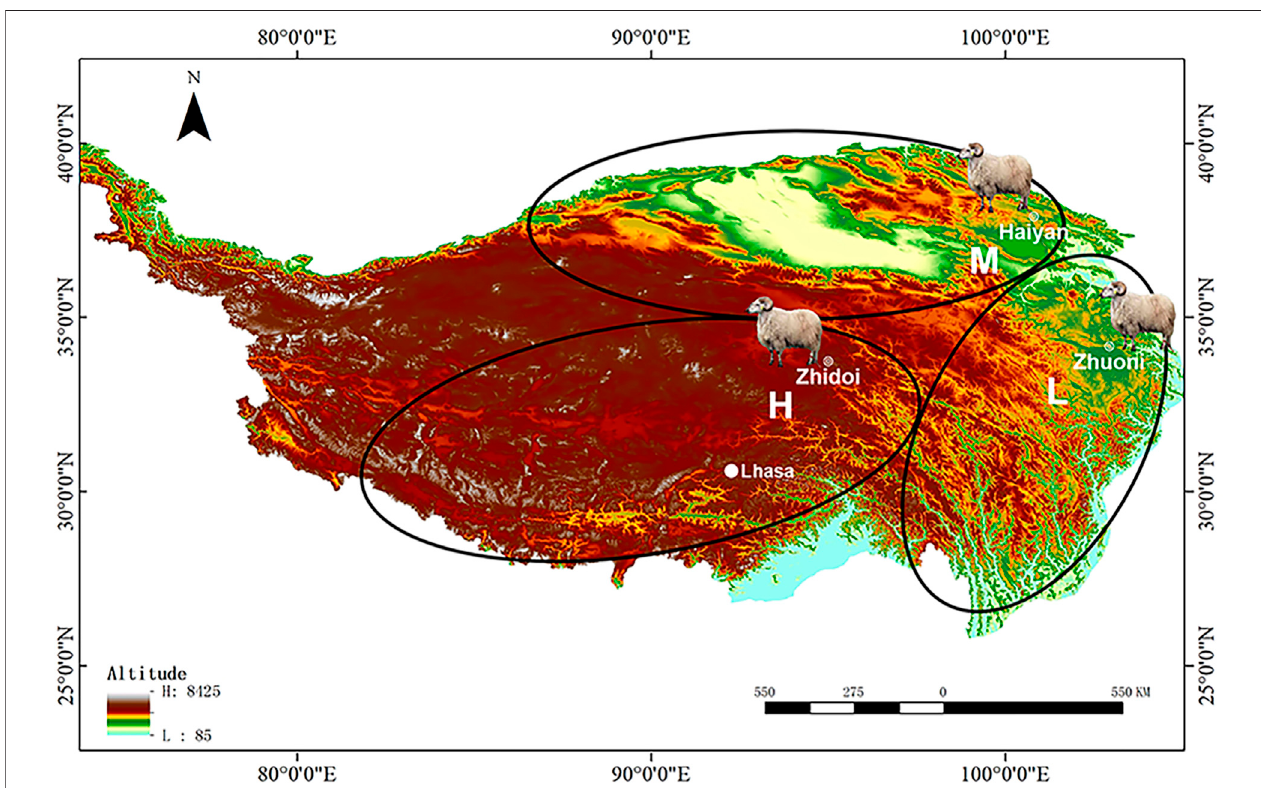
FIGURE 1 | Sampling sites of Tibetan sheep from different altitude distribution areas on the Tibetan plateau. The 2500-m groups from the “ low-altitude ” region at Zhuoni County, Gannan Tibetan Autonomous Prefecture, China; the 3500-m groups from the “ middle-altitude ” region at Haiyan County, Haibei Tibetan Autonomous Prefecture, China; the 4500-m groups from the “ high-altitude ” region at Zhidoi County, Yushu Tibetan Autonomous Prefecture, China. L, M, and H represented low-, middle-, and high-altitude regions,